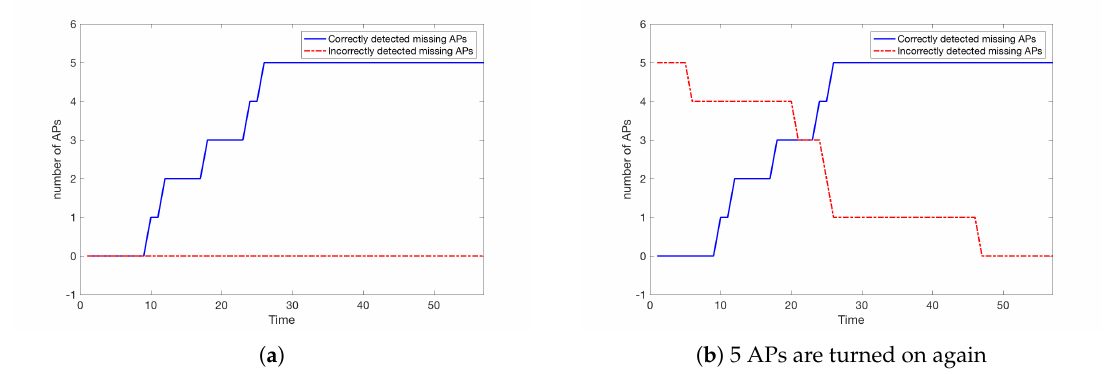
Figure 17. Number of missing APs detected ( K = 30 and 5 APs are not